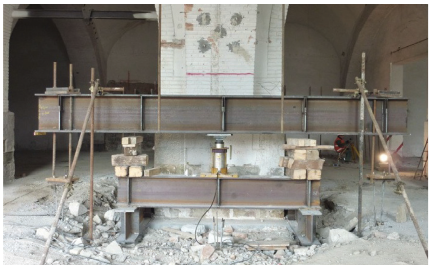
Figure 5: Loading system realized for the tests on foundation plinths.